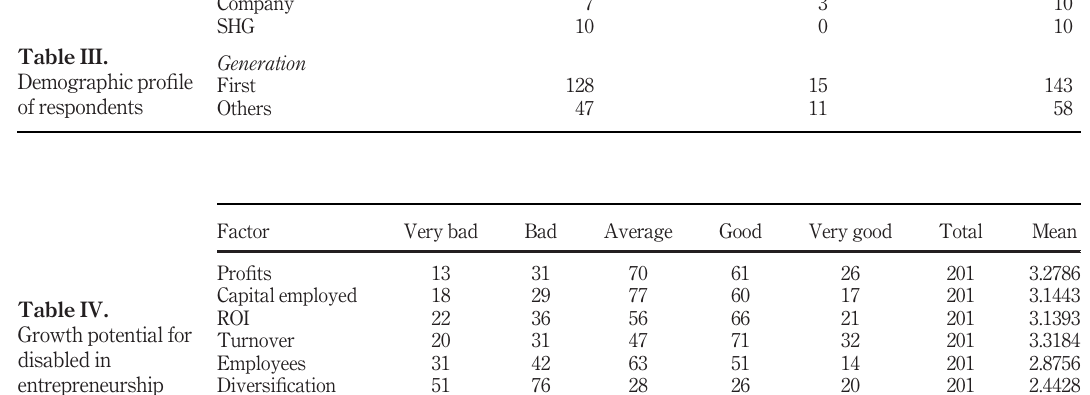
Table IV. Growth potential for disabled in entrepreneurship